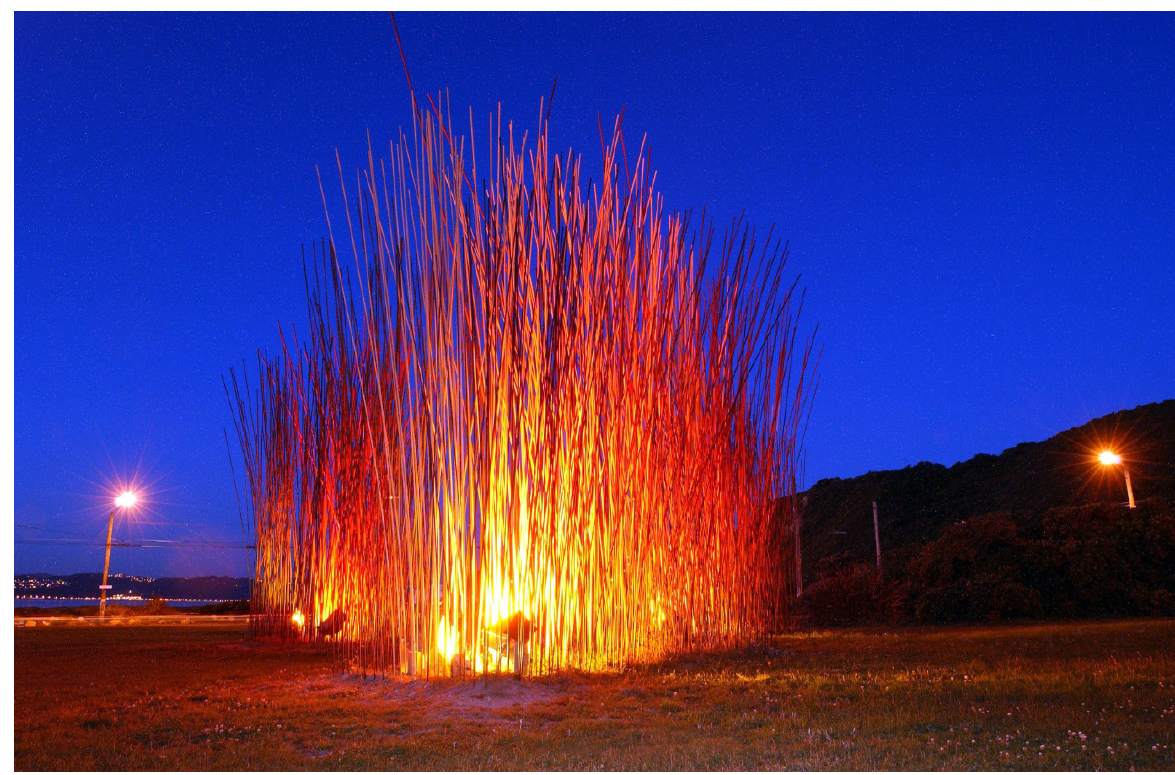
Figure 6. The Light and Kinetic Wind sculpture by K. Dimopoulos,